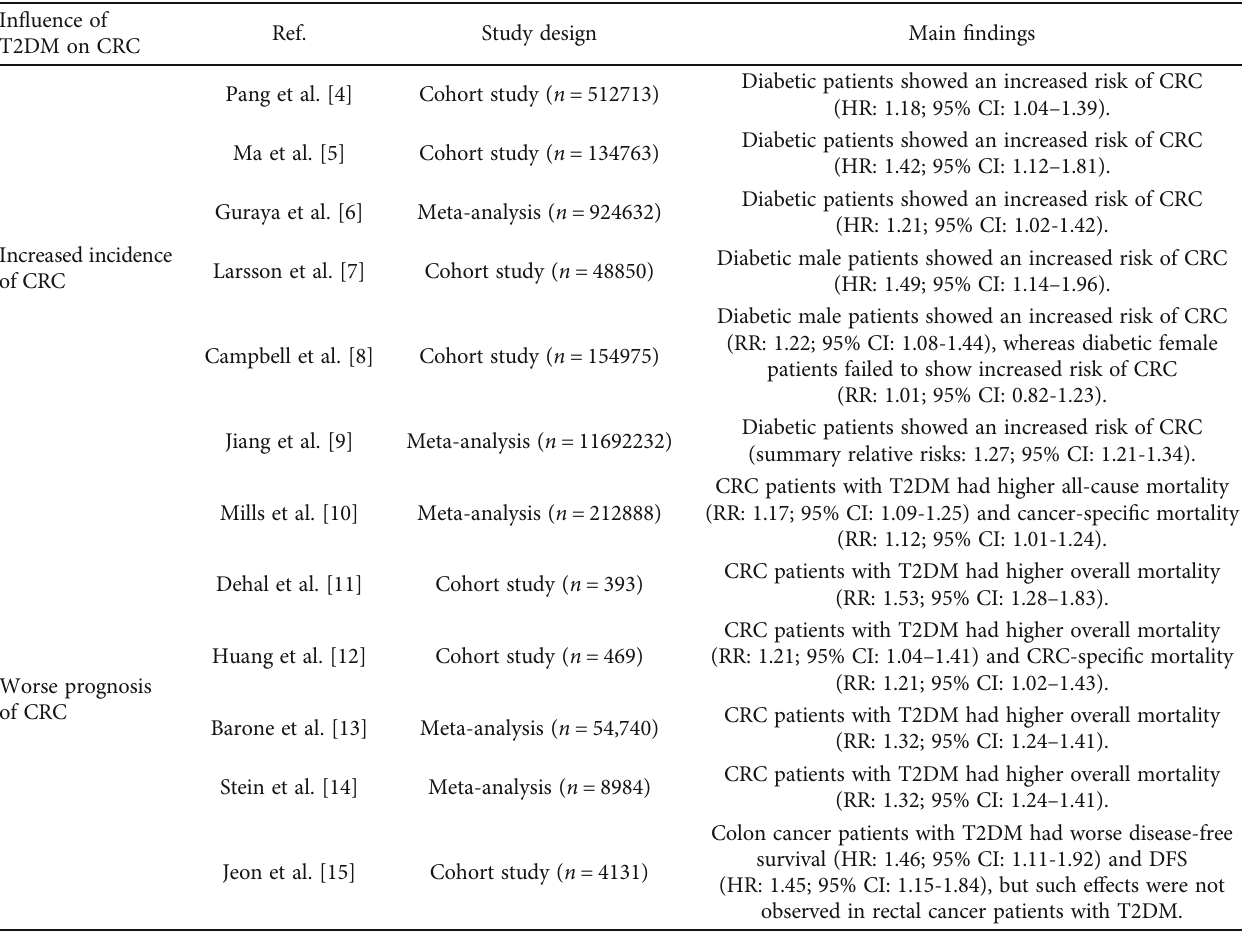
Table 1: Summary of representative association studies between type 2 diabetes mellitus (T2DM) and CRC.